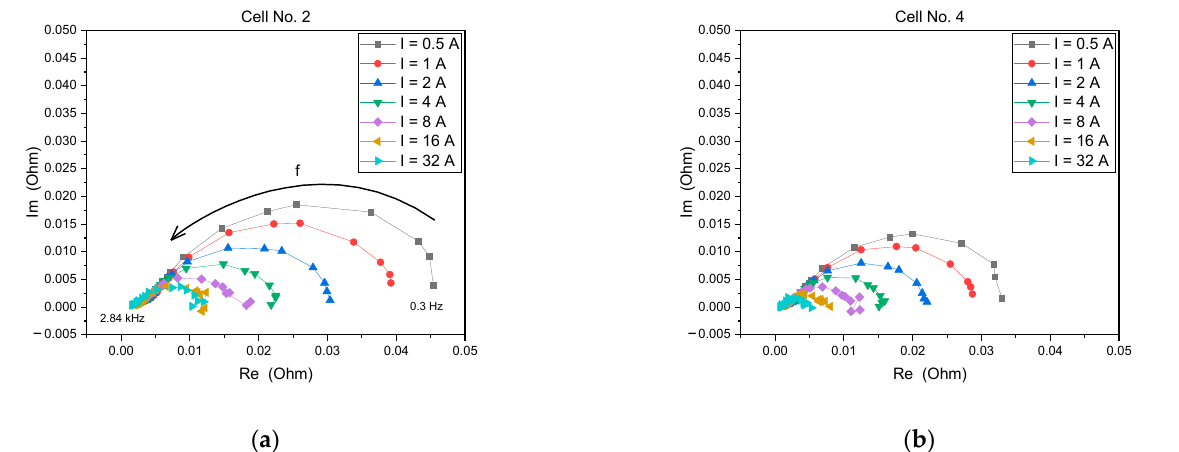
Figure 2. Impedance spectra of the power cells for different current loads I: ( a ) cell No. 2, ( b ) cell No. 4; the impedance (real Re and imaginary Im parts) measurements were recorded at frequencies from 0.3 Hz to 2.84 kHz.